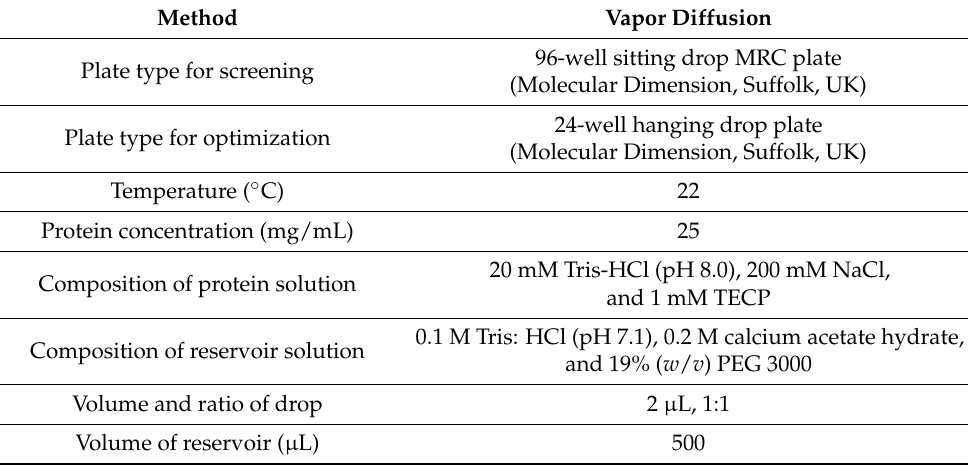
Table 2. Crystallization